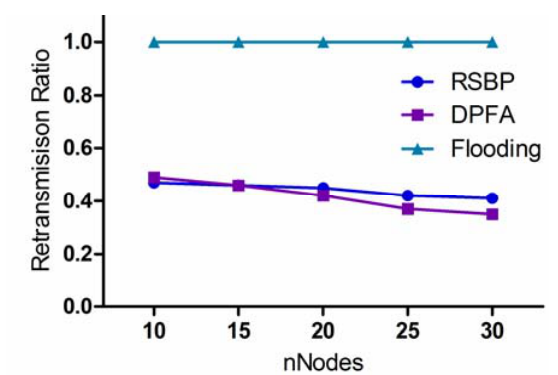
Figure 8. Retransmission